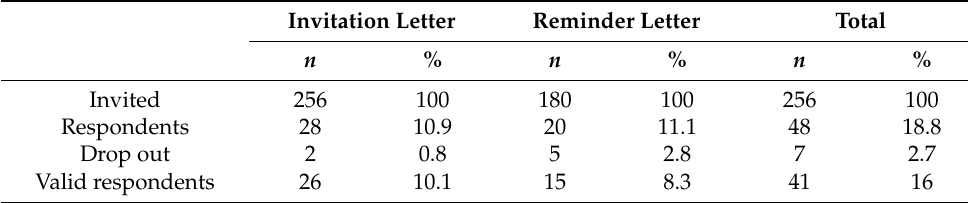
Table 3. Numbers ( n ) and rates (%) of the sample obtained at different stages of the pilot study. Invitation Letter